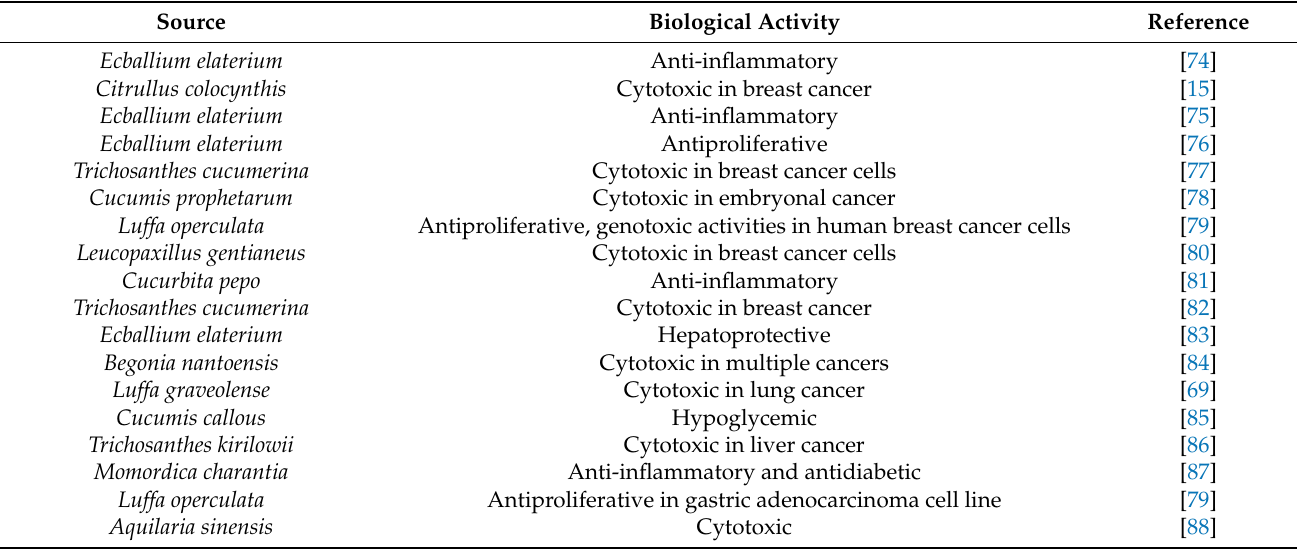
Figure 5. Recent anticancer effects described on different cell signaling pathways by CuB. Upregula- tion ( ↑ ) and downregulation ( ↓ ). Table 2. Source and biological activity of cucurbitacin B.